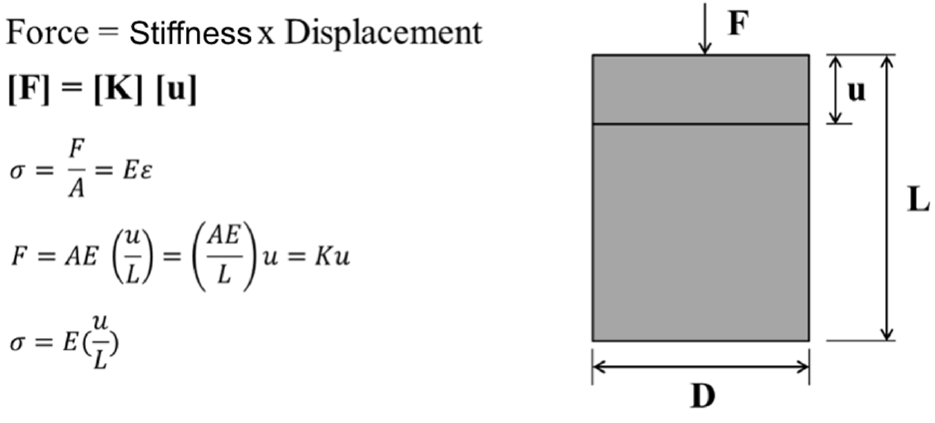
Figure 5. F: column of the force vectors, u: column of the displacement vectors, K: square matrix.